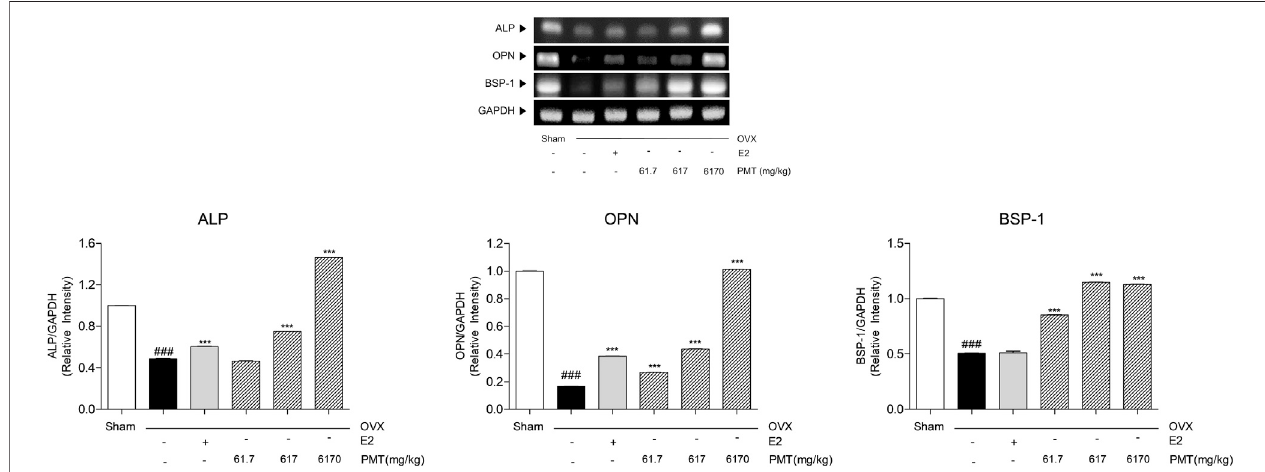
FIGURE5| EffectsofPMTonosteoblasticproductionmarkersinfemur.OsteoblasticproductionmarkerswereanalyzedbyRT-PCR.Resultsarepresentedasthe mean ± standarderror. ### p < 0.001vs.Shamgroup;*** p < 0.001vs.OVXgroup.OVX,ovariectomizedgroup;E2,17 β -estradiolgroup;PMT, Palmul -tangsoftextracts; ALP, alkaline phosphatase; OPN, osteopontin; BSP-1, bone sialoprotein 1.